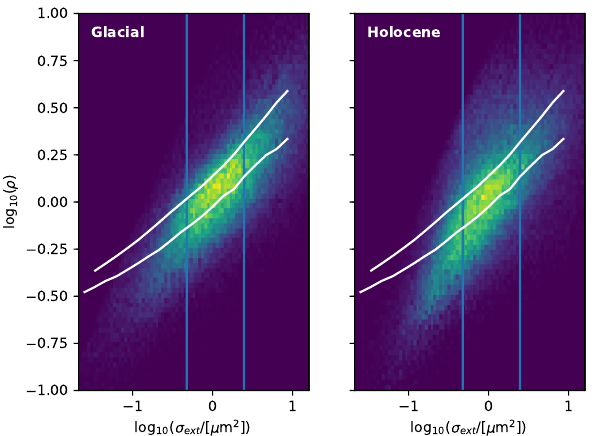
Figure 6. Glacial and Holocene samples measured by SPES. The brighter colors have a higher number of measured particles in a bin. The blue lines mark the 0.25 and 0.75 quantiles of σ ext . The white curves are the mean optical thickness as a function of σ ext for ADDA simulations with a refractive index of 1.55. The upper is for an aspect ratio of 0.5, the lower for